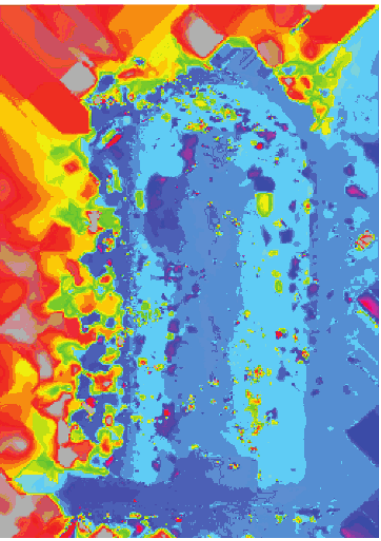
Fig 8. A digital model obtained using the splain